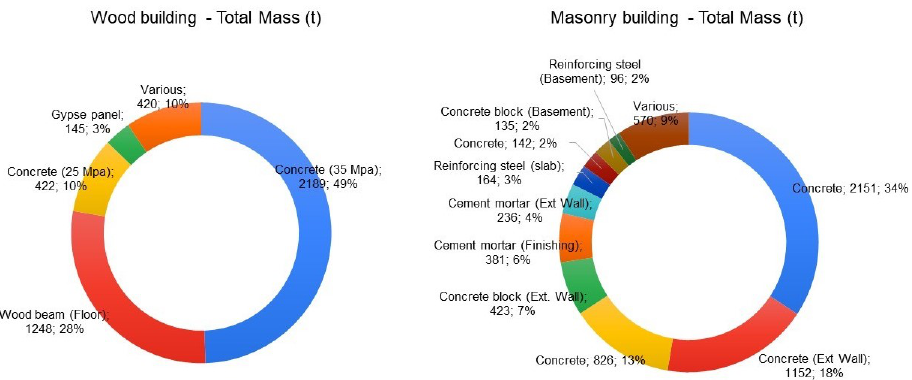
Figure 4. Mass distribution [t] for values the cases studied.